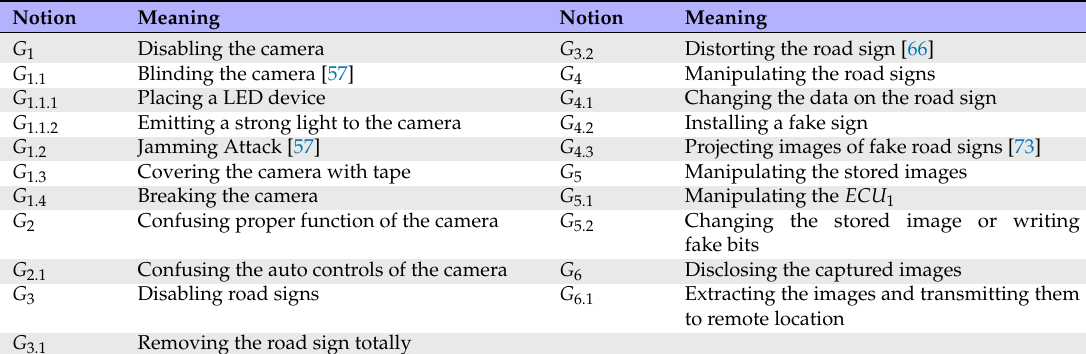
Table 3. Notations and meanings of